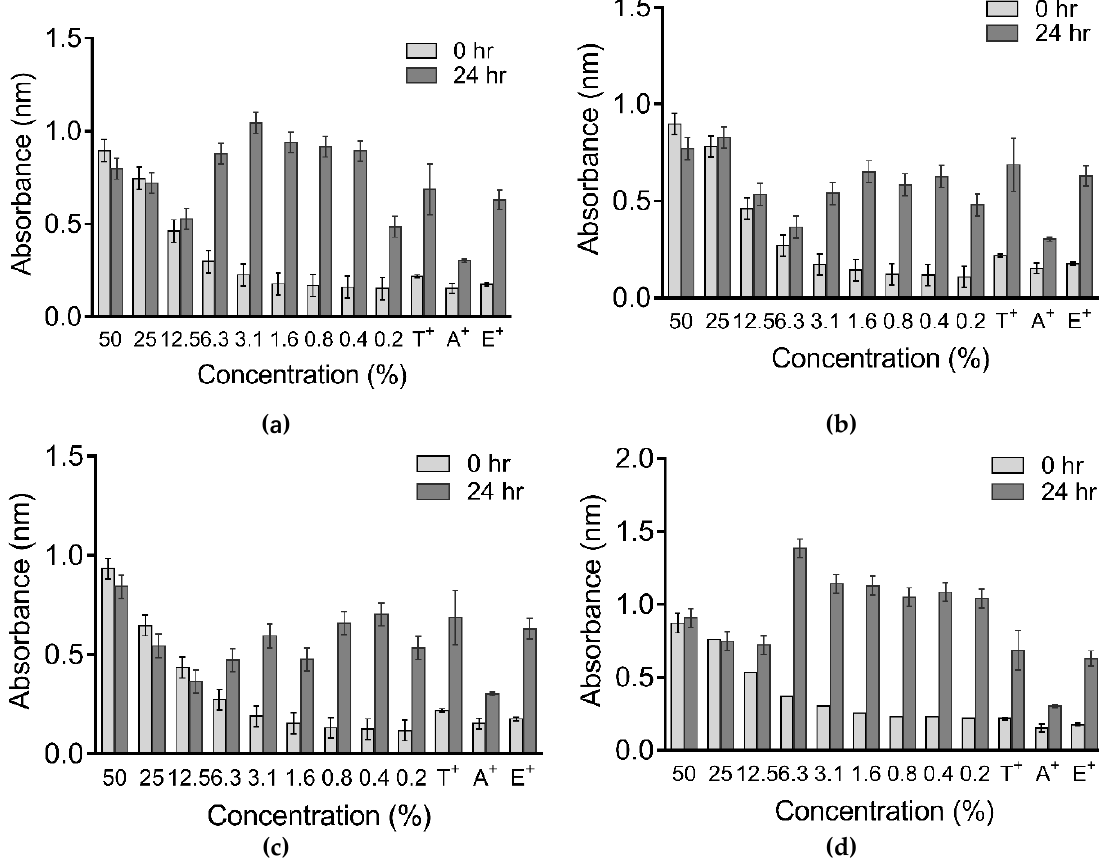
Figure 5. Absorbance of various concentrations of ( a ): E. coli , ( b ) S. typhi , ( c ): Shigella and ( d ) K. pneumonia. The absorbance was measured at 0 h and after 24 h of incubation. T: tetracycline, A: amoxycillin, and E: erythromycin were used as positive controls.